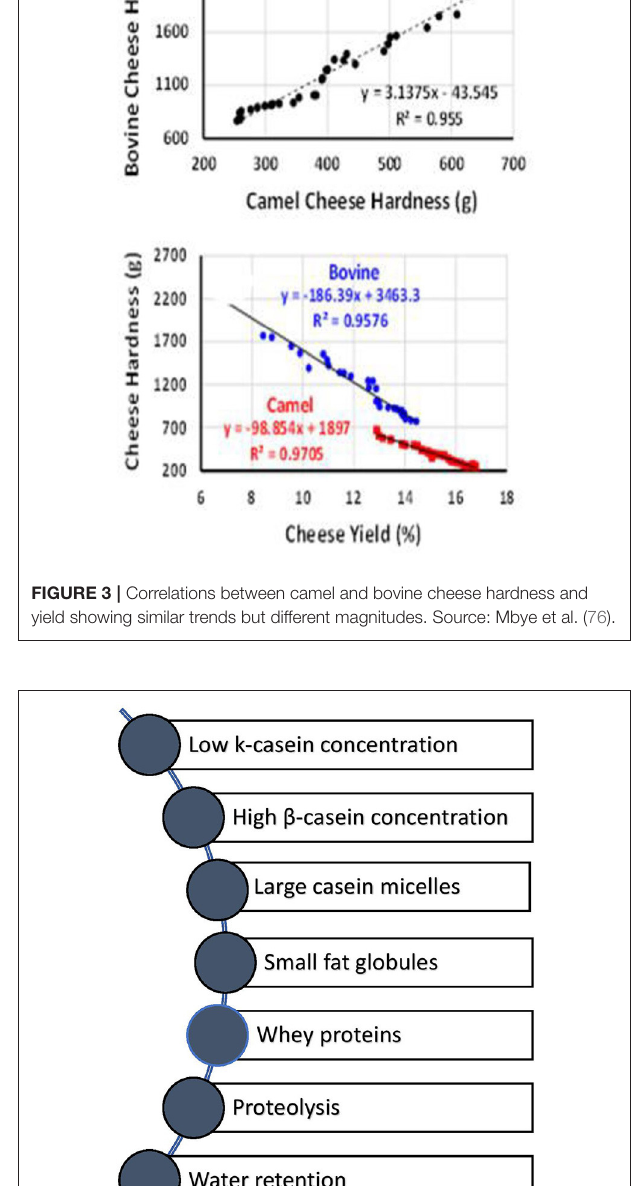
is recommended to avoid pasteurizing cheese milk for more than 65 ◦ C for 30 min or 72 ◦ C for 15 s (27, 48). It was found that CM coagulates slowly when the temperature exceeds 65 ◦ C for 30 min resulting in cheeses with weak gels (18, 99, 103,